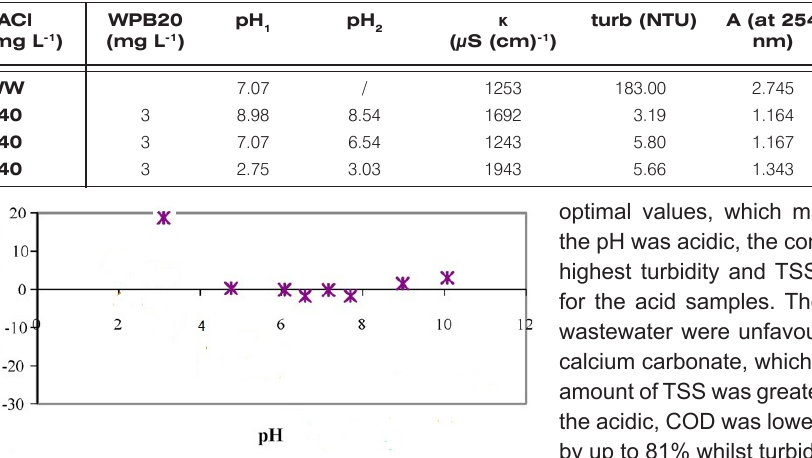
Figure 1. Zeta potential of WPB20 (denoted as x) and WPB40 (denoted as l) as a function of